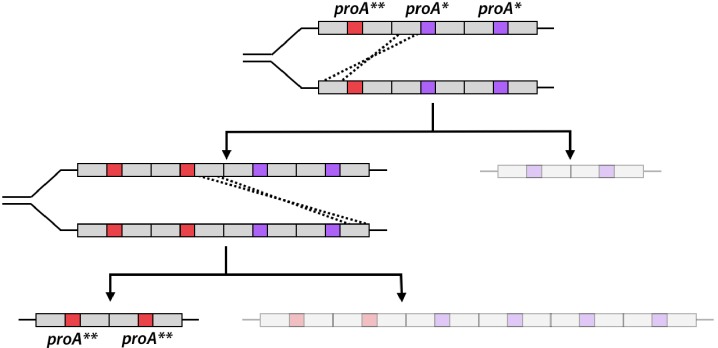
Homologous recombination of an amplified proA* array with one proA** allele can rapidly lead to a daughter cell with only proA** alleles.Each arrow represents one homologous replication event. The genotype of the less-fit daughter cell from each recombination event is grayed out.